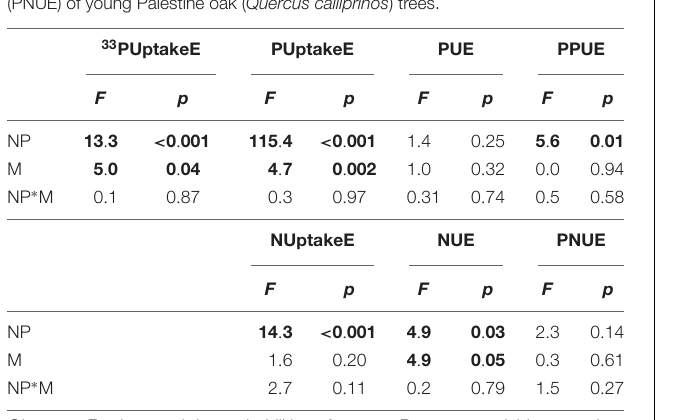
TABLE 1 | Two-factorial analyses of variance (ANOVA) on the significance of the effects of the soil N:P ratio (NP), soil moisture (M), and their interaction on the variance of instantaneous 33 PUptake efficiency ( 33 PUptakeE), long-term P uptake efficiency (PUptakeE), P use efficiency (PUE), instantaneous late-summer photosynthetic P use efficiency (PPUE), N uptake efficiency (NUptakeE), N use efficiency (NUE), and instantaneous late-summer photosynthetic N use efficiency (PNUE) of young Palestine oak ( Quercus calliprinos ) trees.